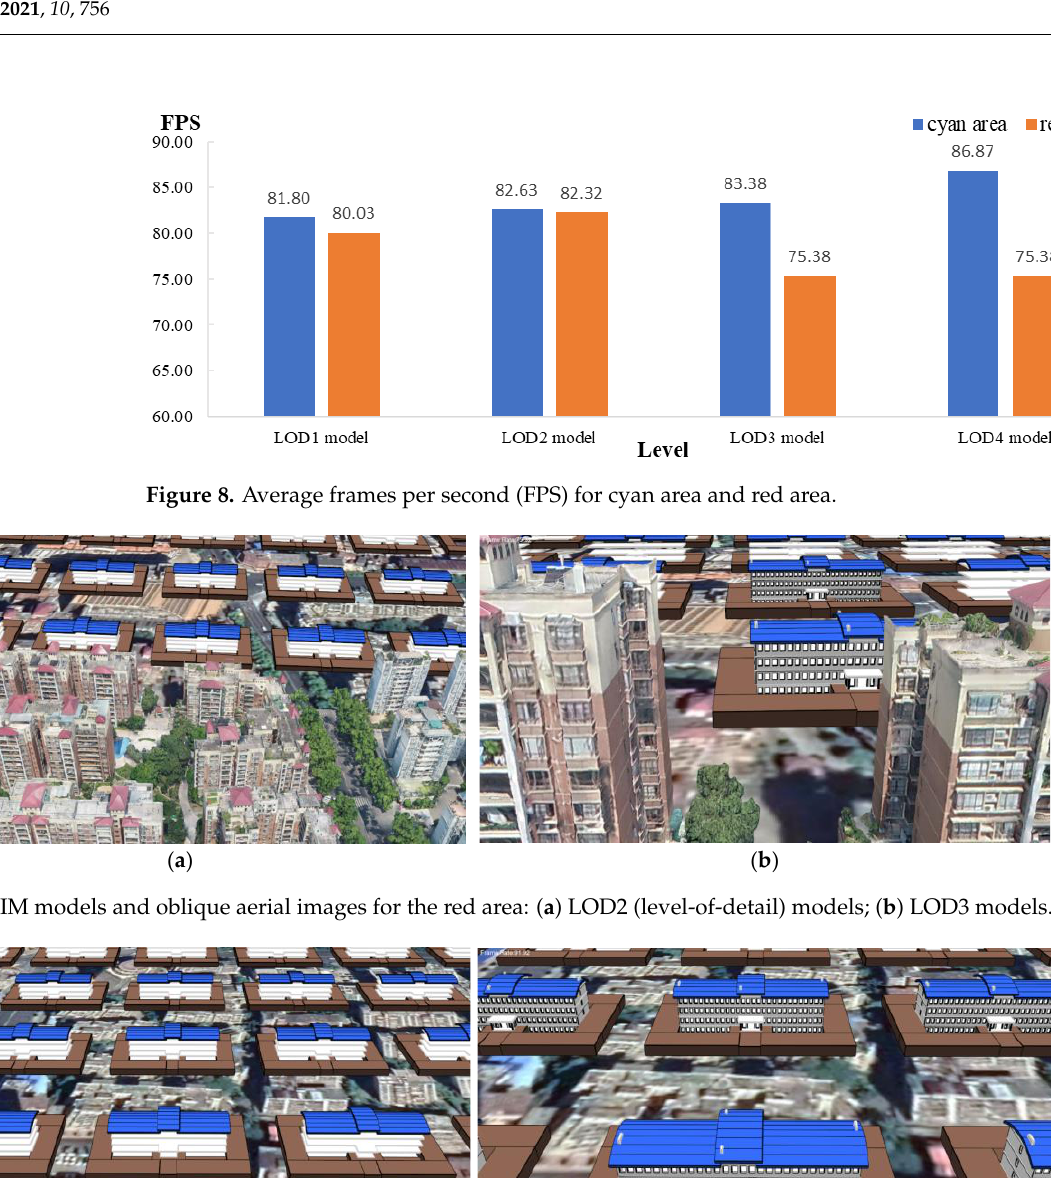
ISPRS Int. J. Geo-Inf. 2021 , 10 , 756